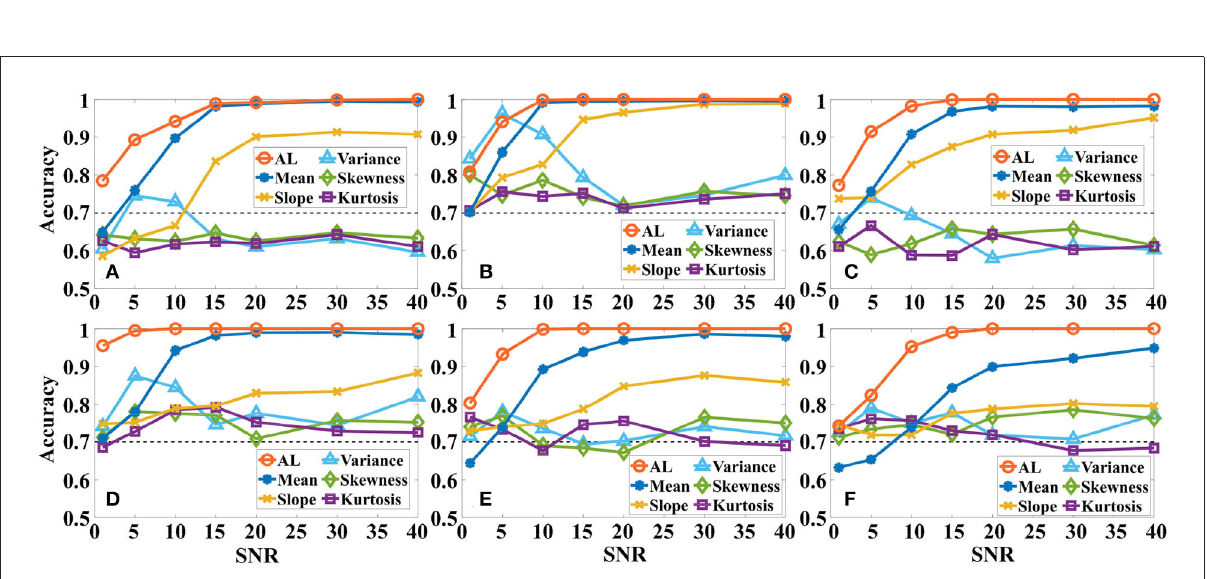
FIGURE8 The effect of different levels of Gaussian white noise on the classification accuracy of the same a-GMM classifier based on level feature and BPF-statistical features. (A–F) Correspond to the accuracy results of simulations 1–6. AL is an abbreviated form of activation level.